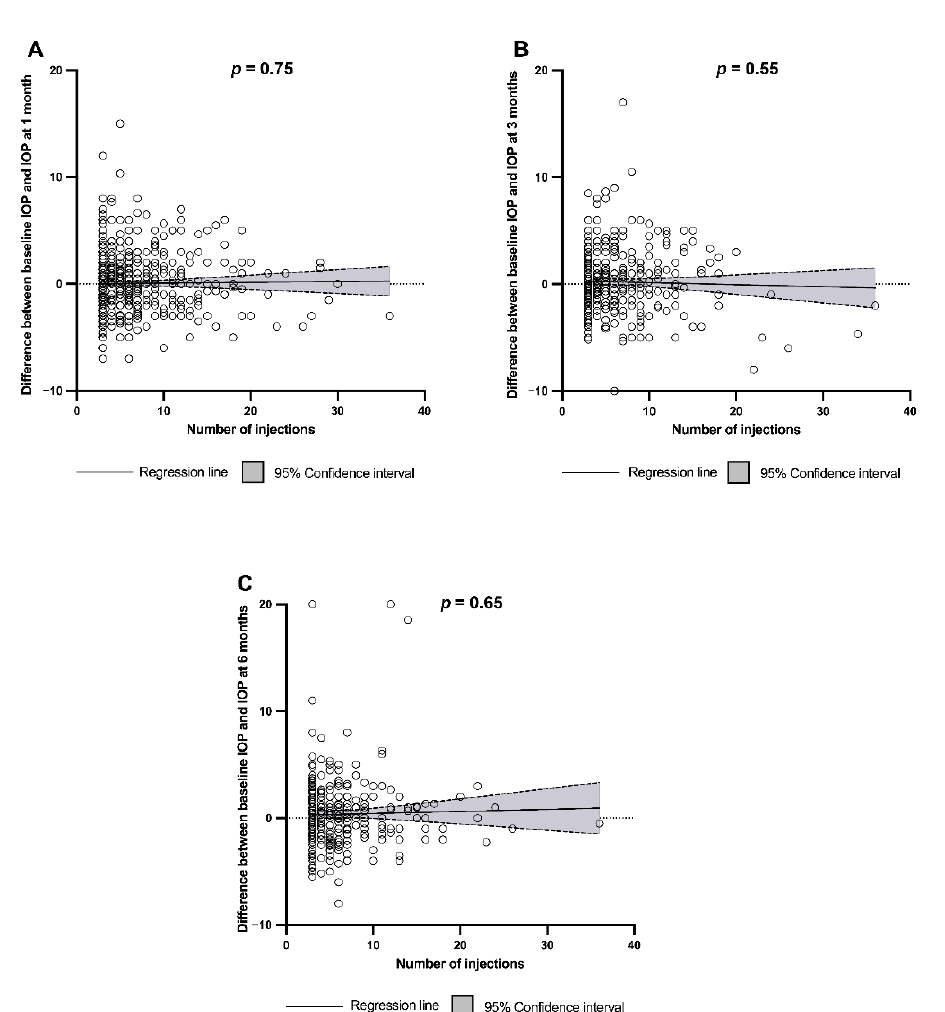
Figure 3. Variation between baseline intraocular pressure and intraocular pressure at 1, 3, or 6 months ( A – C , respectively) according to the number of injections. IOP = intraocular pressure; p value testing the null hypothesis that the linear regression line slope is zero.